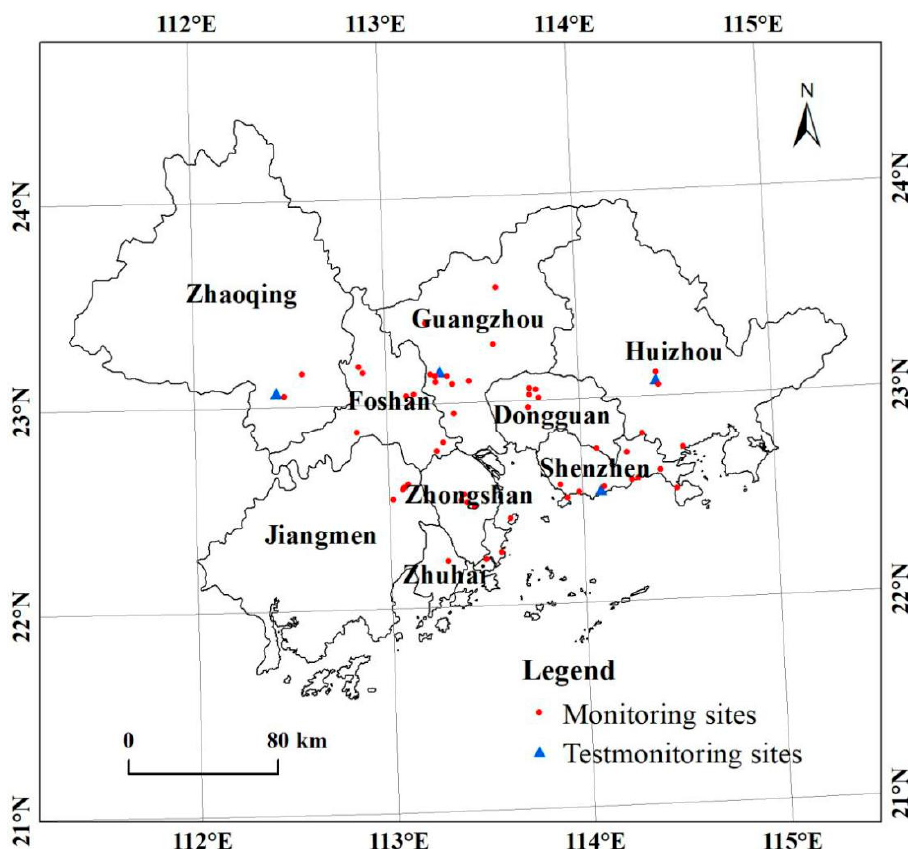
Figure 1. The geographical location of the study area.